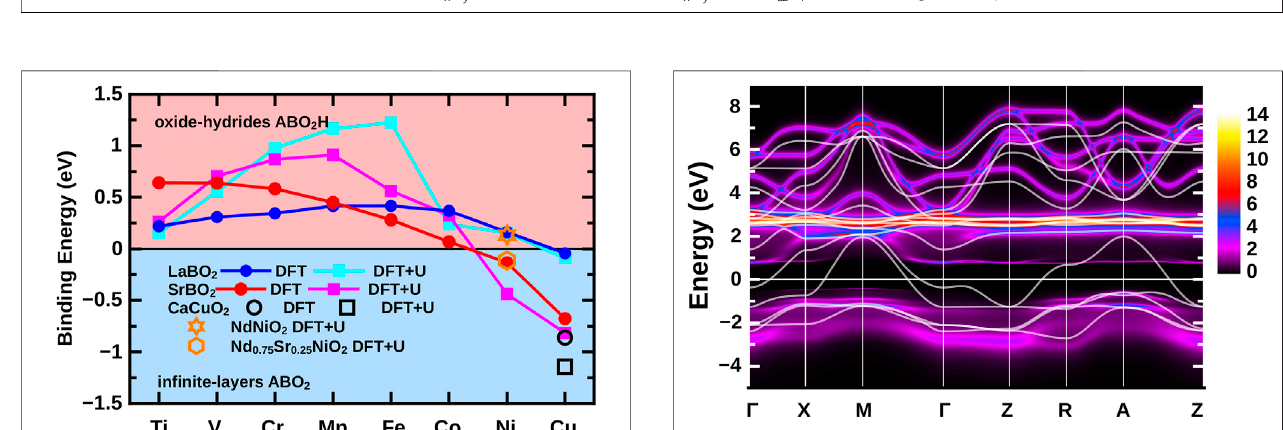
FIGURE 7 | Reduction of Sr x Nd(La) 1 − x NiO 3 with CaH 2 may result not only in the pursued end product Sr x Nd(La) 1 − x NiO 2 but also in Sr x Nd(La) 1 − x NiO 2 H, where H atoms occupy the vacant O sites between the layers. This has dramatic consequences for the electronic structure. In a fi rst, purely local picture, visualized on the right side, there is instead of Ni 3 d 9 with one-hole in the 3 d x 2 − y 2 orbital, two holes in the 3 d x 2 − y 2 and 3 d 3 z 2 − r 2 orbital forming a local spin-1.